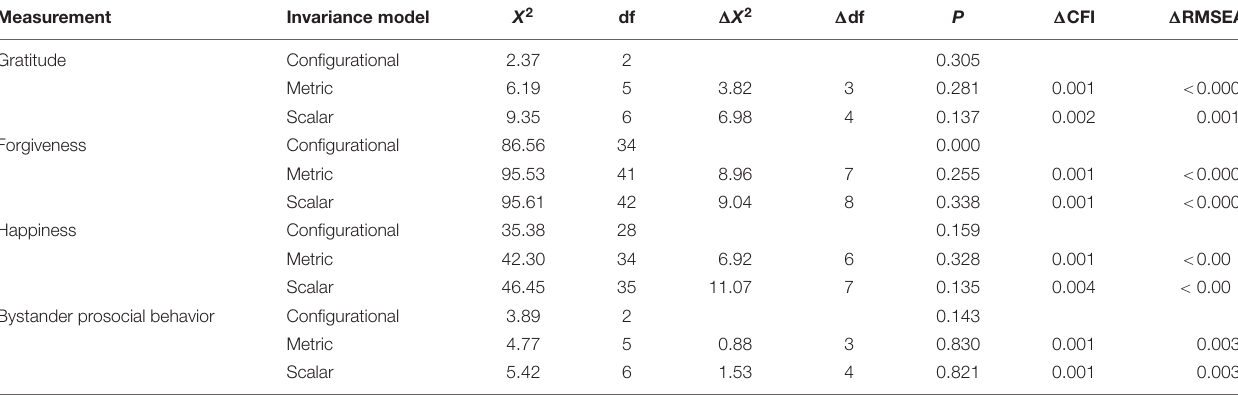
TABLE 3 | Test of stage of adolescence invariance: summary of goodness-of-fit statistics. Measurement